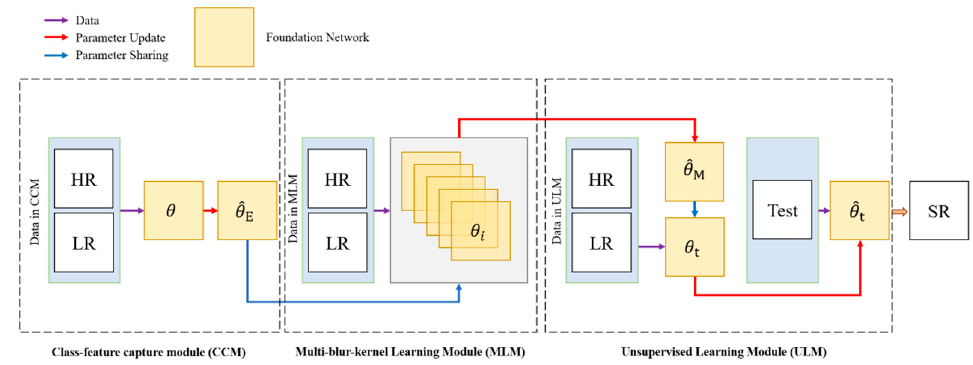
Figure 1. The overview of the Multiple-blur-kernel Super-resolution Framework (MSF).